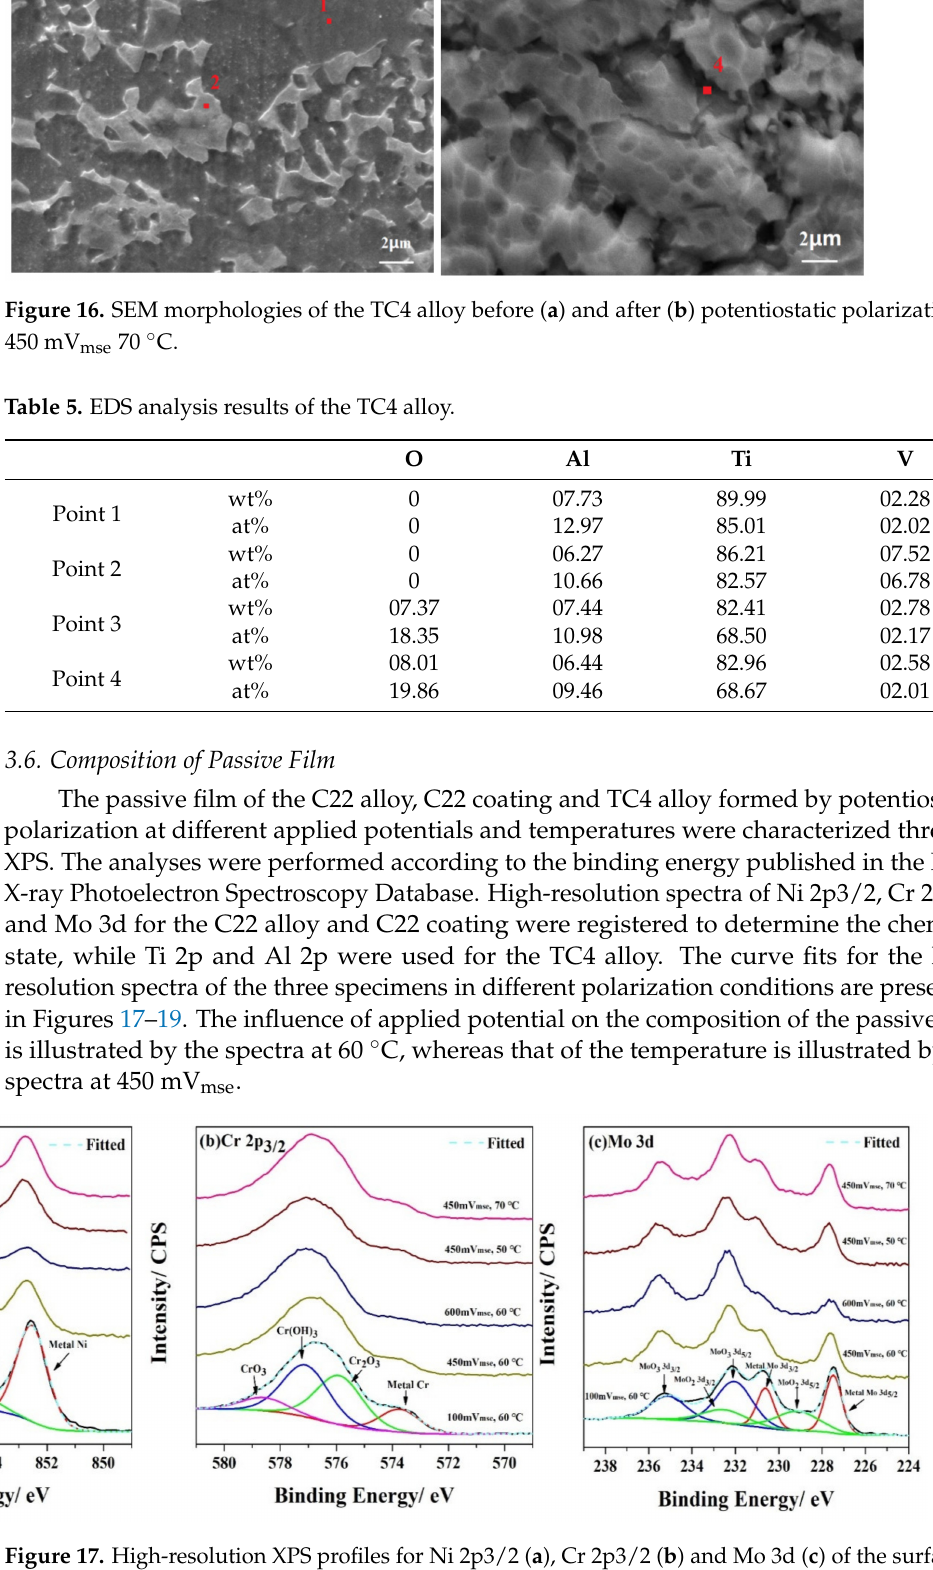
Figure 17. High-resolution XPS profiles for Ni 2p3/2 ( a ), Cr 2p3/2 ( b ) and Mo 3d ( c ) of the surface of the C22 alloy after potentiostatic